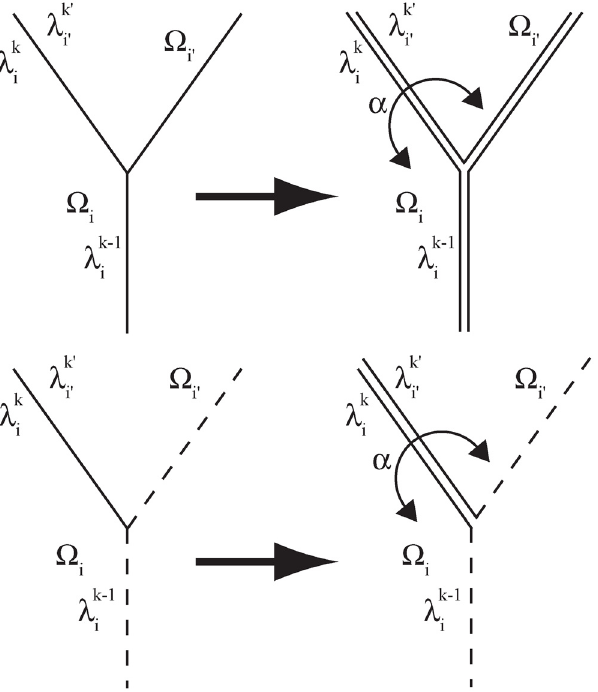
Fig 2. The Y -shaped edge junction issue. Left: the description of the population fluxes between l k (cid:3) 1 is not trivial due to the Y -shaped edge junction. Right: each interior edge (= corridor) has been duplicated (at the same position), leading to a “ V -shaped ” junction between l k (cid:3) 1 edges. The exchange rate between the populations from both sides of the edge, l k the parameter α